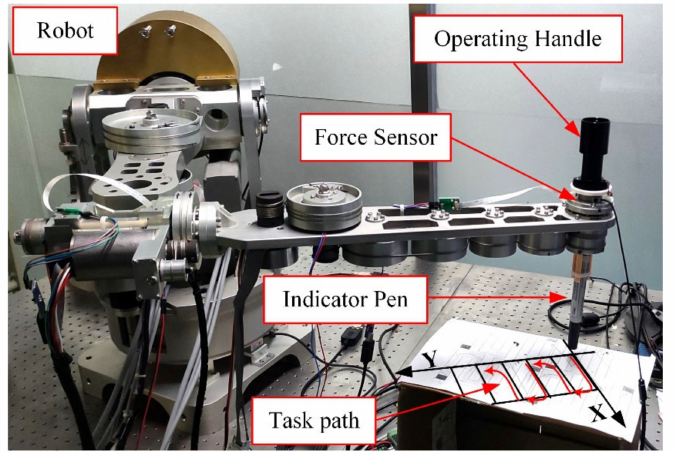
Figure 5. Experimental setup with designated task